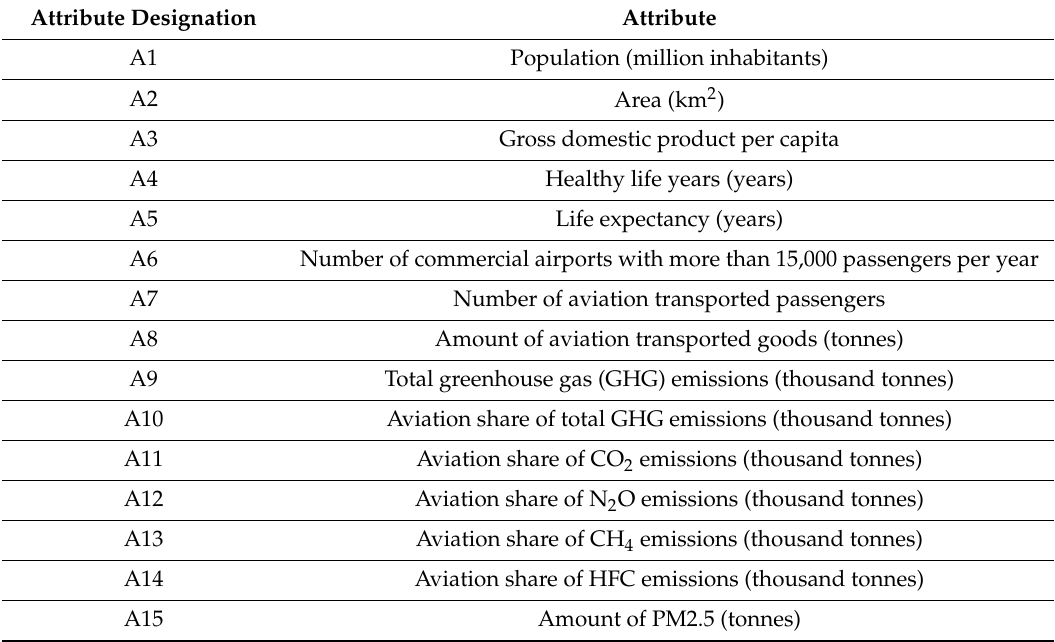
Table 1. Selected attributes characterizing the 27 European Union (EU-27) member states (2018). Attribute